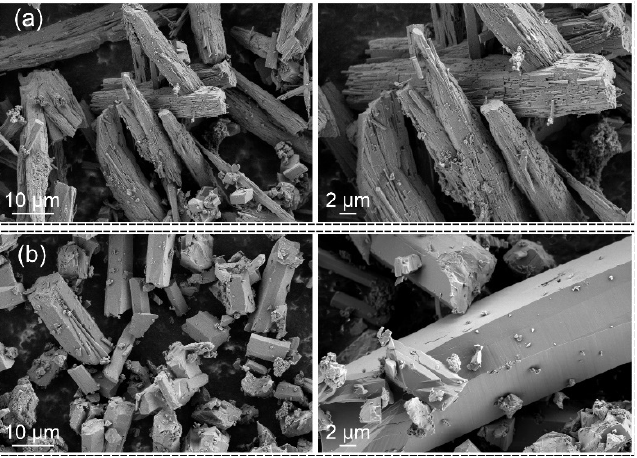
Figure 3. SEM images of calcium carbonate deposits: a) calcite and b)